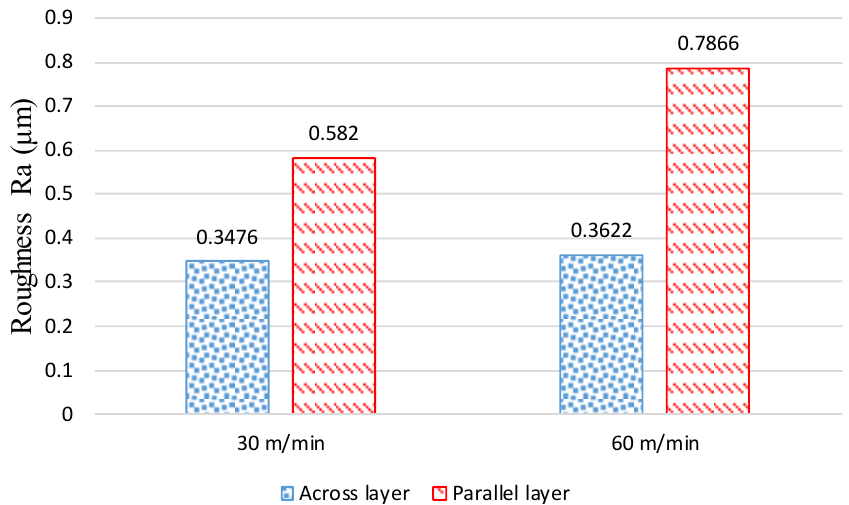
Figure 5. Surface roughness measured for AL and PL orientations at V = 30 and 60 m/min, f = 0.1 mm/rev, and d = 0.2 mm.